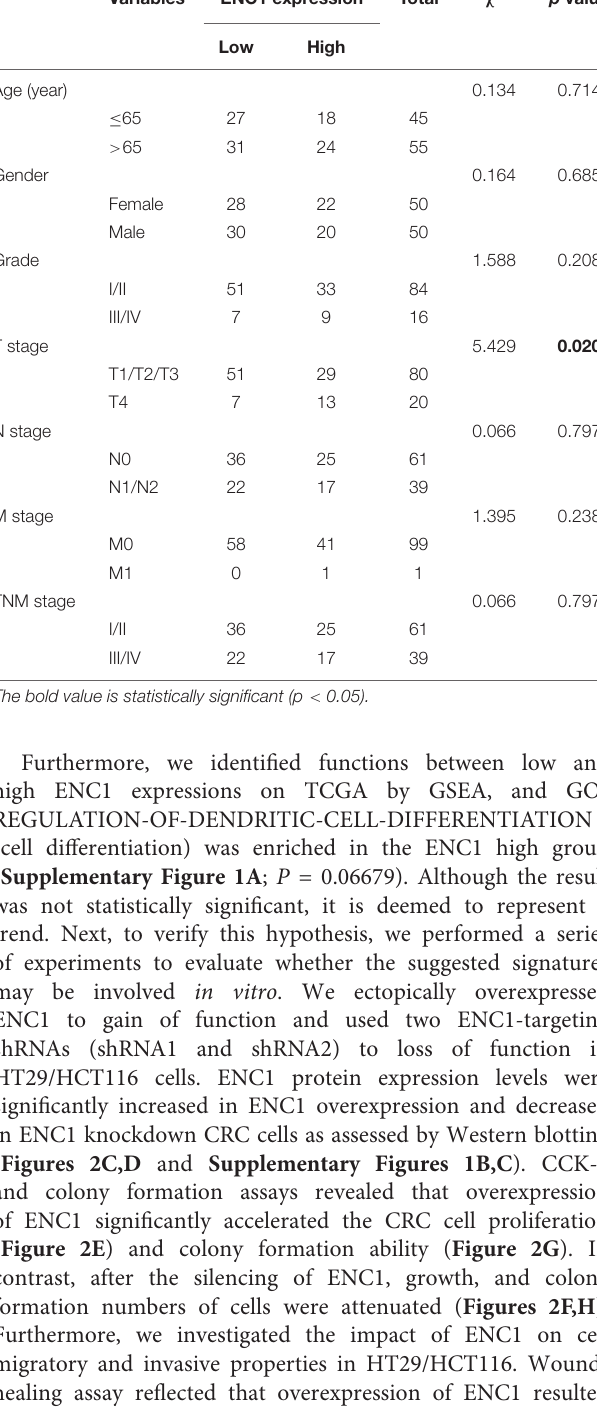
TABLE 1 | Correlation between ENC1 expression and clinicopathological features in 100 CRC patients.